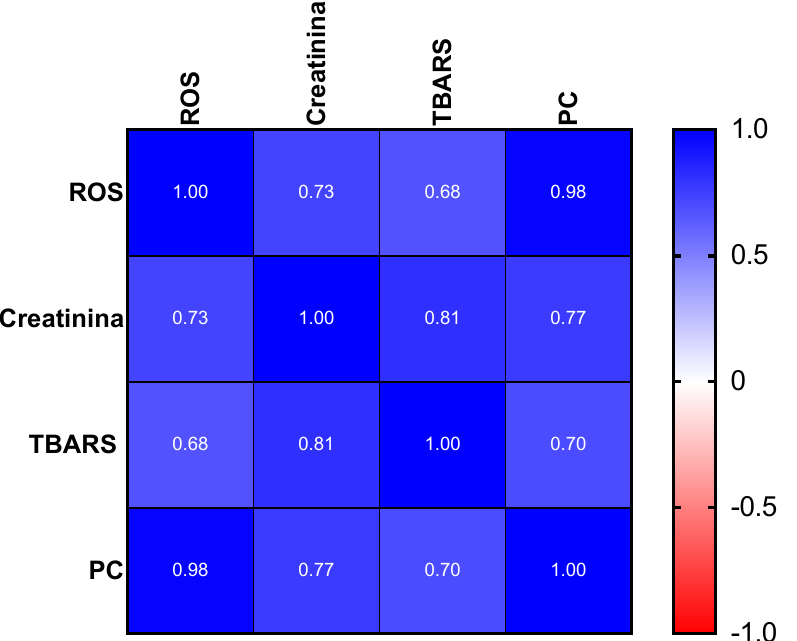
Figure 5. Heat map chart of creatinine levels and oxidative stress biomarkers in plasma: ROS, TBARS, and PC. The correlation coefficient (r) is reported in the squares.